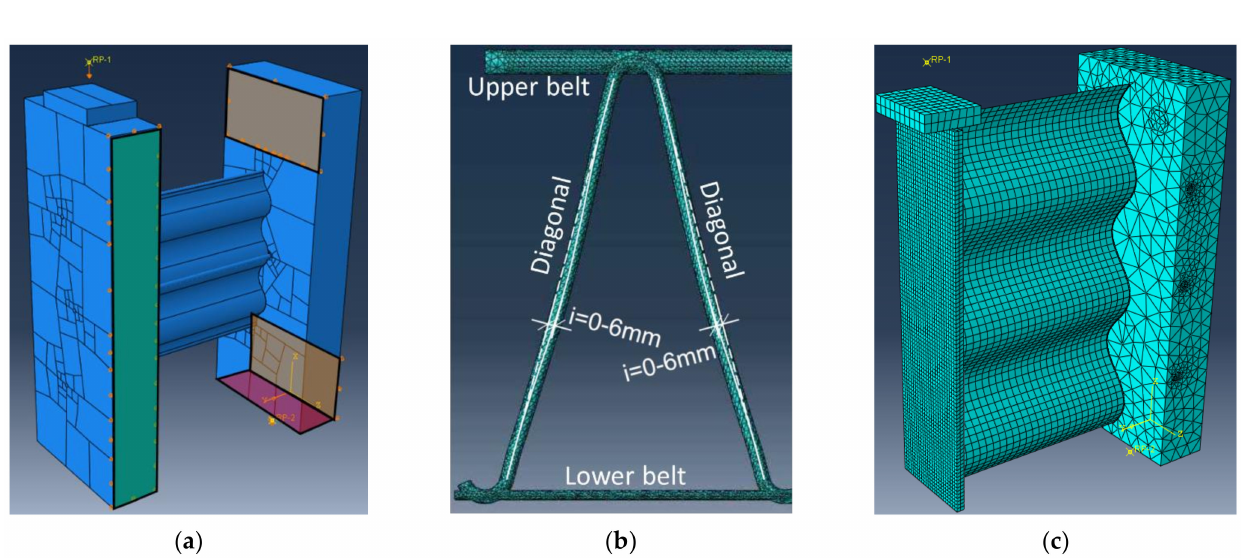
Figure 5. Modelling of tested specimen in Abaqus: ( a ) Double wall with KAP-steel-connector, showing the boundary conditions: vertical support (red), horizontal support (orange), symmetry (green), deformation at the Reference point ( b ) 9 mm Lattice girder with pre-deformed geometry, deformation towards the lower belt ( c ) Concrete panel with SIN-beam after mesh